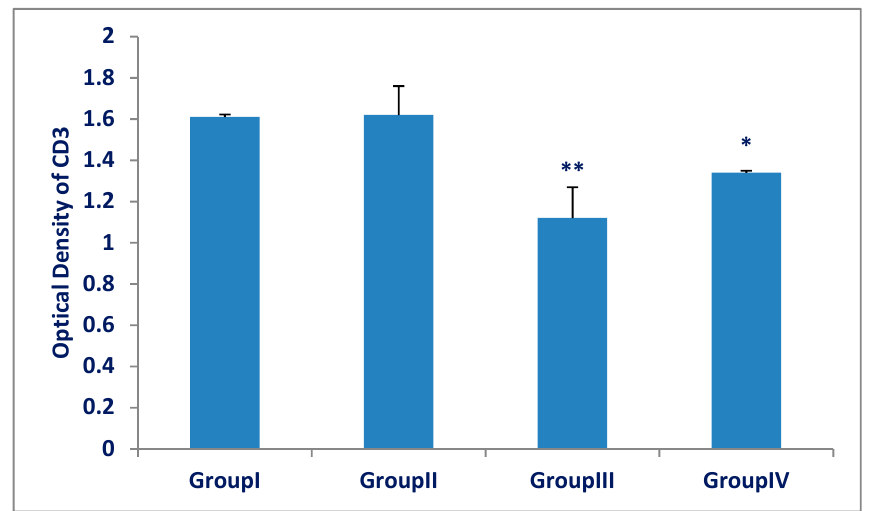
Figure 6. The optical density of CD3 in the spleens of group (III) (Olanzapine-treated group) was significantly decreased as compared to group (I) (control group). A significant increase in group (IV) (Olanzapine and vitamin C) as compared to group (III). The differences in optical density between group (I) and group (II) were not significant ( p > 0.05). Results are expressed as mean ± SD and the level of significance was set for p -values less than 0.05. **: significant decrease, group (III) versus group (I) ( p < 0.001). *: significant increase, group (IV) versus group (III) ( p < 0.001).